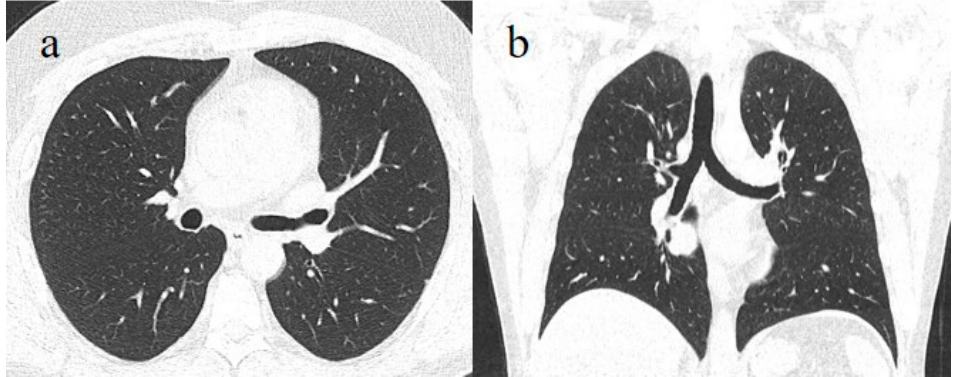
Figure 1. Chest CT showed absence of COVID-19 pneumonia with normal lung appearance on the ( a ) axial plane and ( b ) coronal plane.